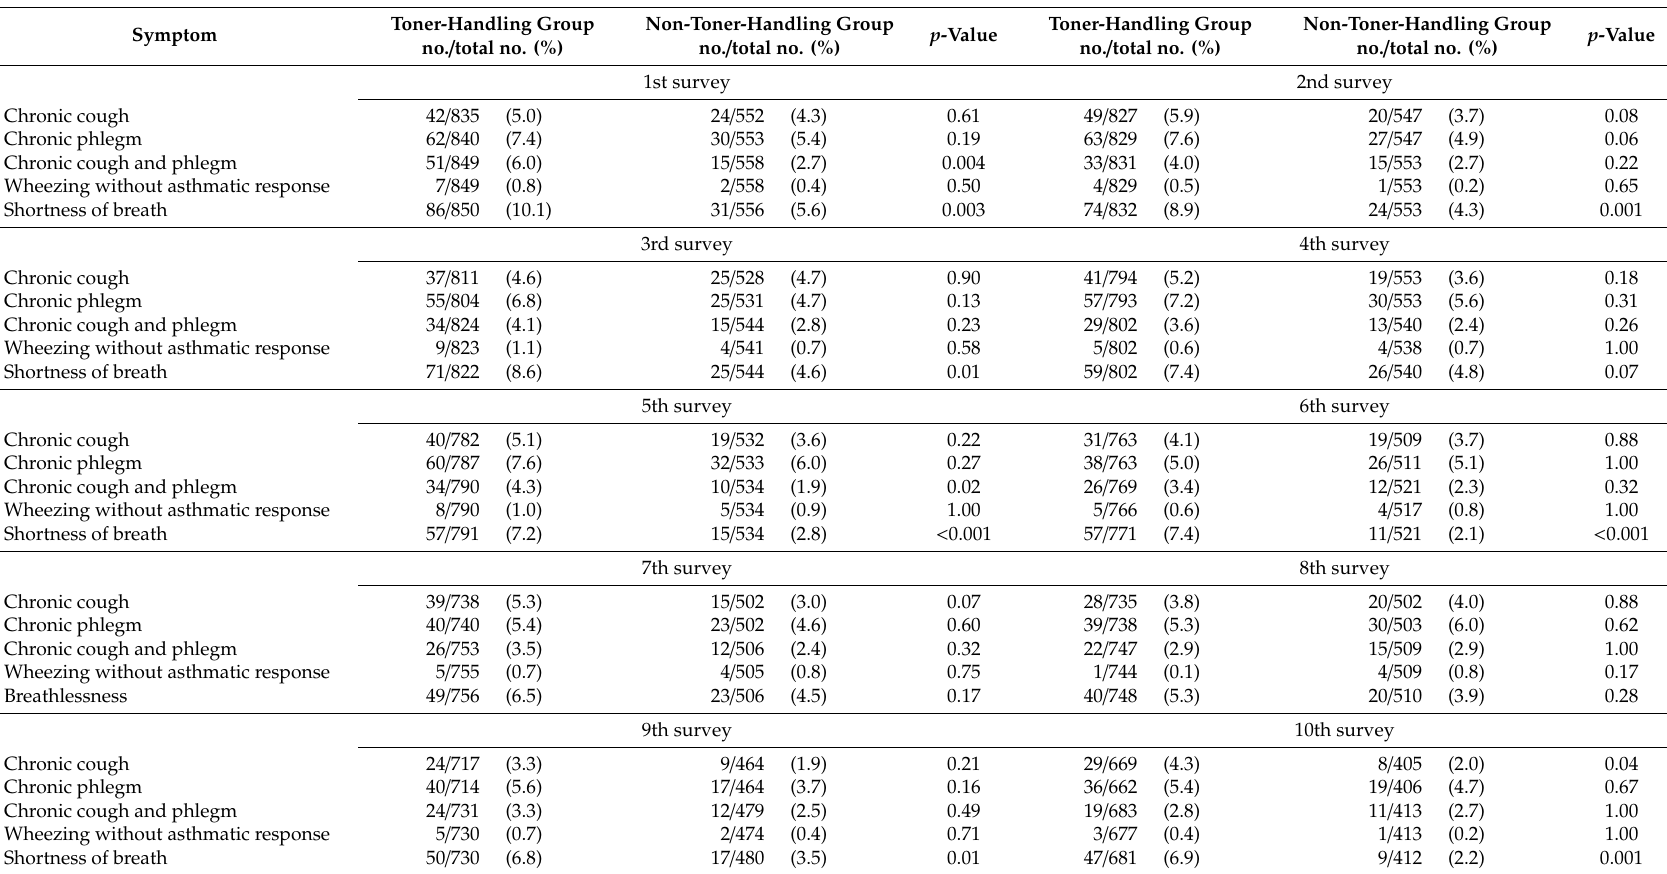
Table 3. Comparison of respiratory symptoms between the toner-handling group and non-toner-handling